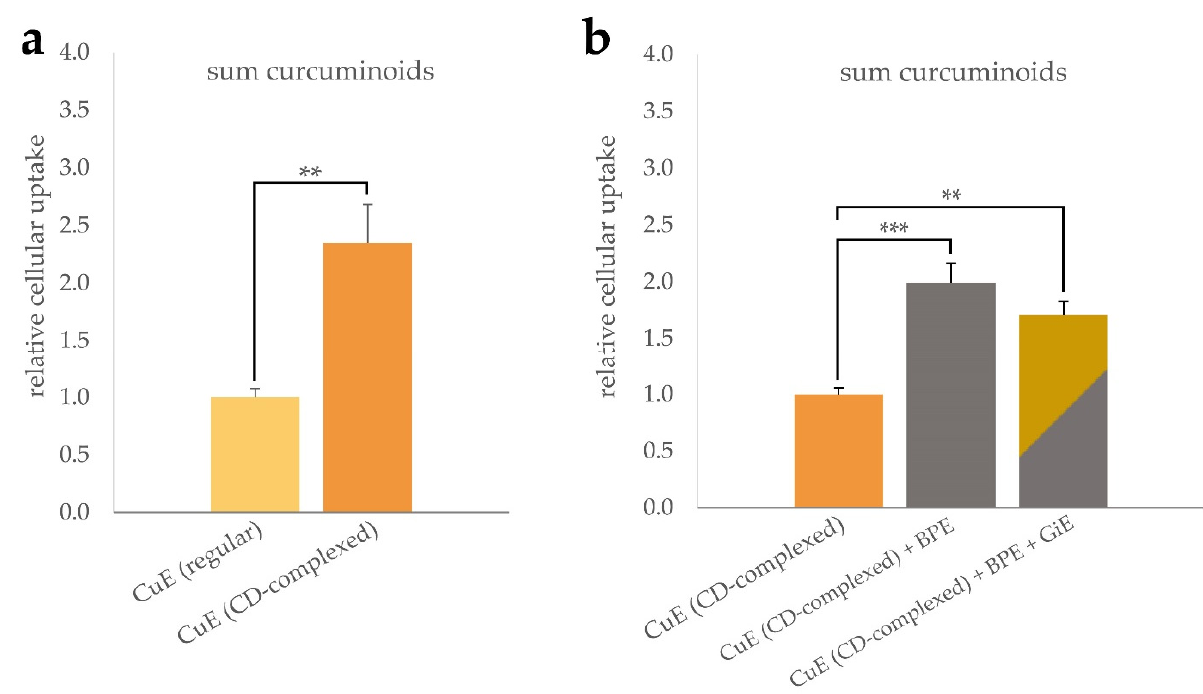
Figure 1. Uptake of curcuminoids in differentiated CaCo ‐ 2 cells. Cells were incubated for 4 h with regular or CD ‐ complexed curcuma extracts at a final concentration of 2.95 μ g/mL of total curcuminoids. For comparison of the formulations, the cellular curcuminoid content was determined and, after normalization to the protein content, the relative cellular uptake was calculated with reference to the regular extract ( a ). Influence of BPE and GiE at concentrations of 6 μ g/mL and 59 μ g/mL on the curcuminoid uptake were normalized to CuE ( b ). In both cases, control experiments without addition of CuE were performed. Error bars represent mean ± SEM ( n > 6). Statistically significant differences are denoted as ** ( p ≤ 0.01) and *** ( ≤ 0.001). Corresponding raw data are available in Supplementary Tables S1 and S2.